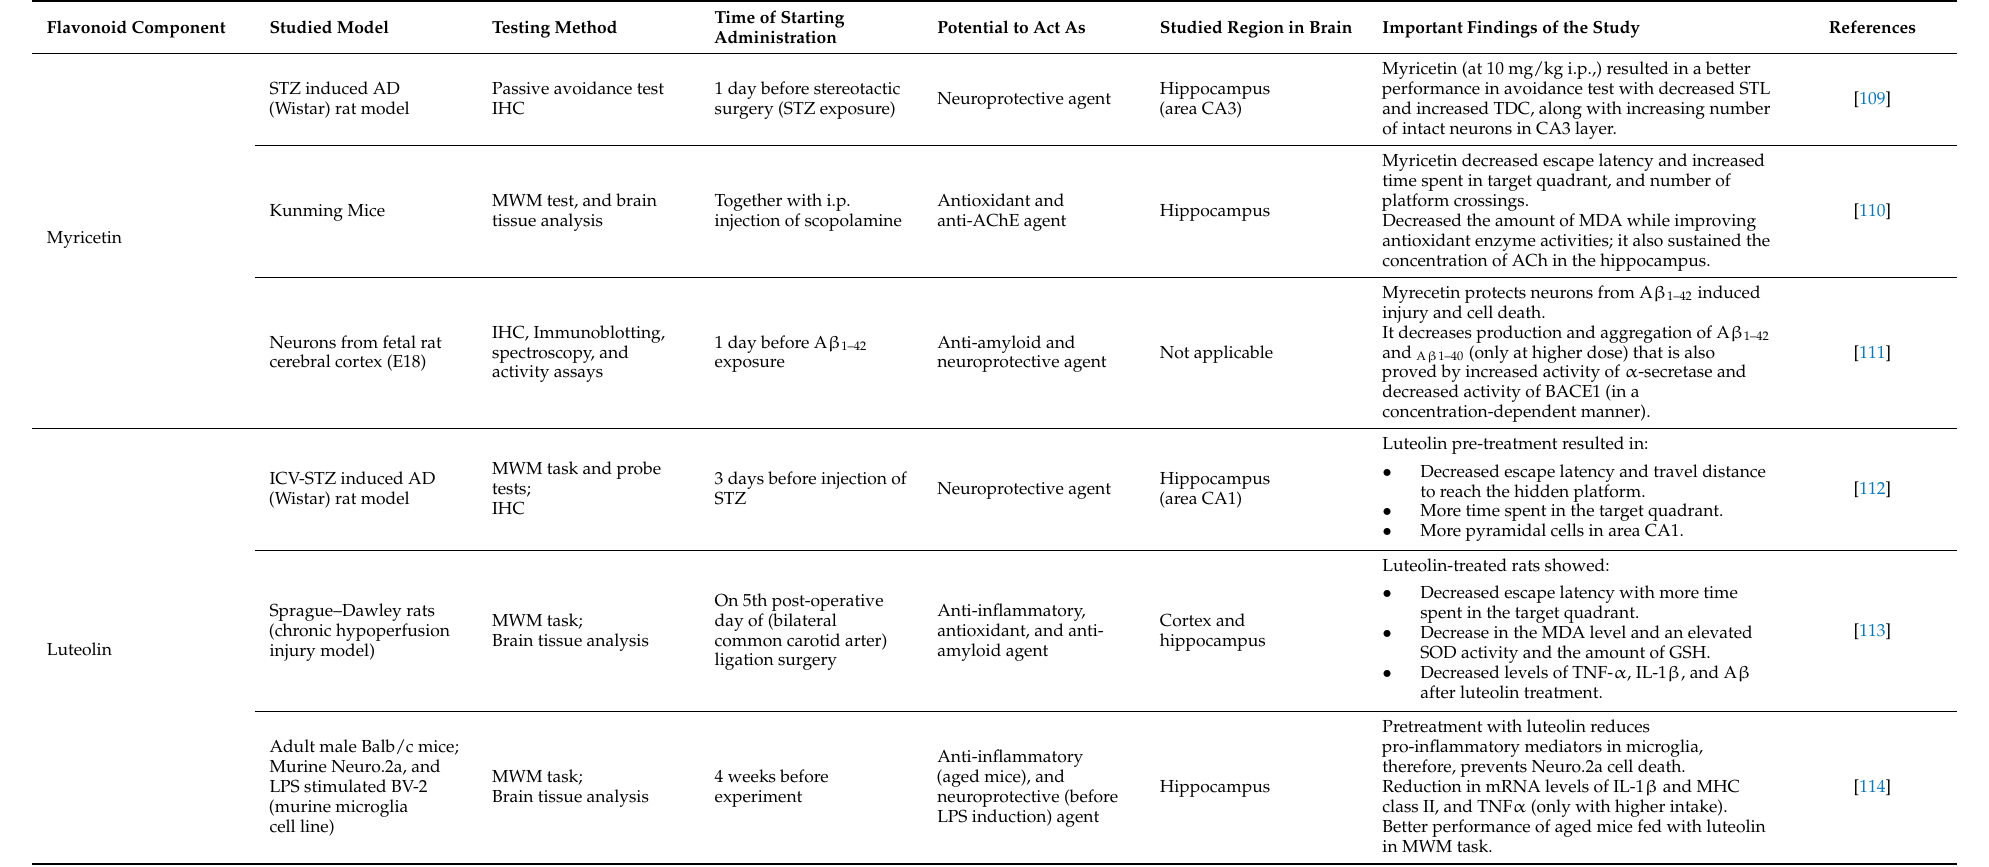
Table 1. Main flavonoid compounds affecting the physiological functioning and/or the pathophysiology of the central nervous